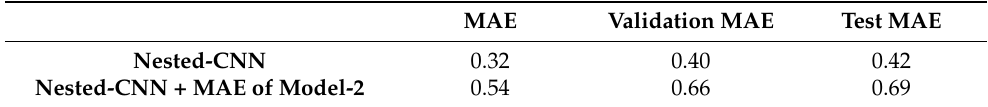
Table 6. Mean absolute error of nested-CNN after training process, the MAE of the nested-CNN by considering the MAE of